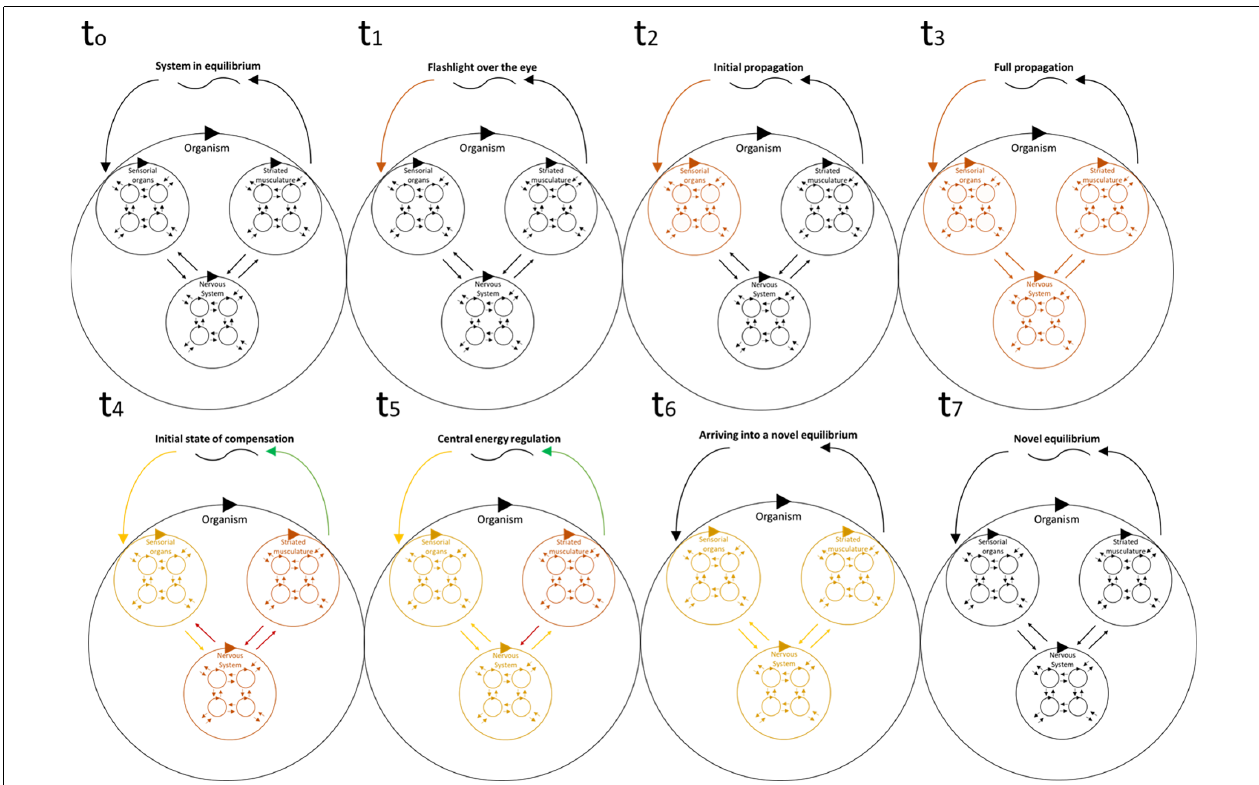
FIGURE 2 | A simplified version of Figure 1B depicting temporal dynamics driven by external stimuli that push the system out of its energetic equilibrium. This figure does not intend to be an exhaustive description of the temporal dynamics of this process, rather to depict some critical features of such dynamics. In particular, that the energy demand imposition of the initial stimulus would only be detected by the sensory regions, and then propagate into the remaining areas. We also emphasize that these regions are bidirectionally related, so that, before the behavior occurs, it is expected that some energy compensations of single neurons and neural networks will take place. When the system is in full propagation of the energy demand imposed by the environment, a behavior will take place impacting the perceived environment. This will have an effect on the sensory areas. However, the impact is not immediate, and it will return to a propagation process in which the mechanisms of all levels (neuron, neural networks, organism) will find a novel